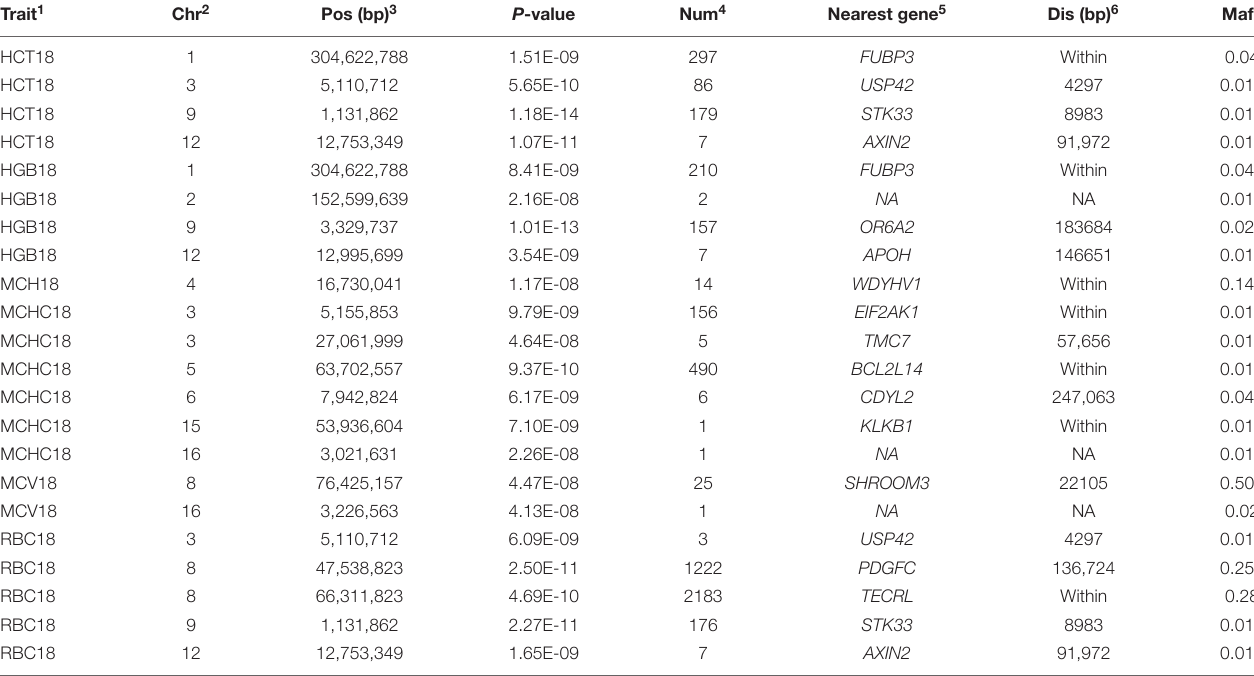
TABLE 1 | Genome-wide significant loci associated with erythroid traits at day 18 obtained by single-trait GWAS. Trait 1 Chr 2